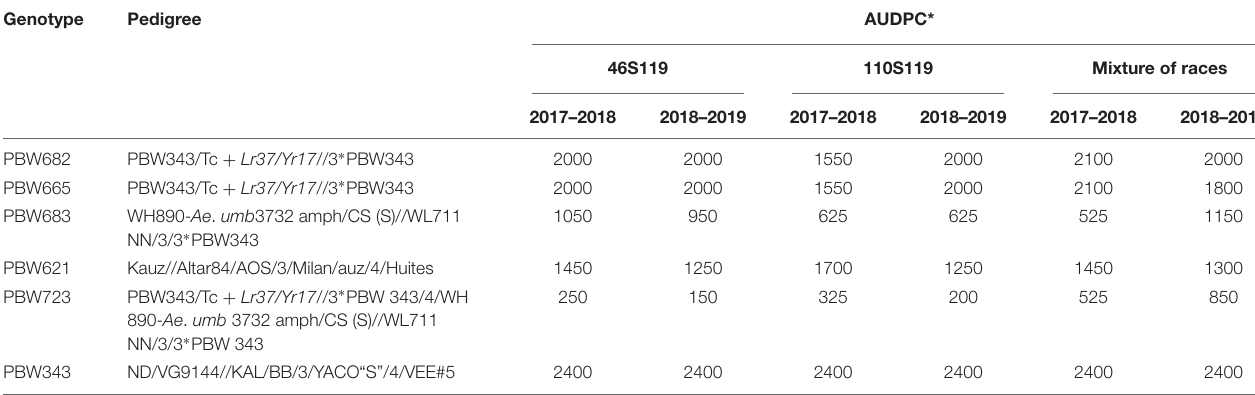
TABLE 11 | Role of defeated genes in contributing resistance to stripe